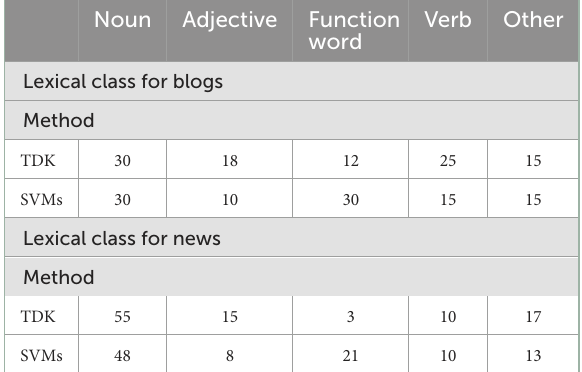
TABLE 10 Distribution of the lexical classes among the top 100 keywords.